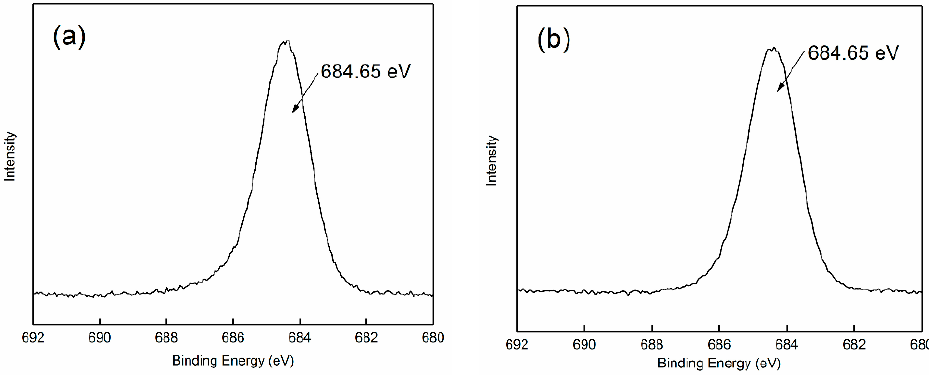
Figure 7. F 1s spectra of ( a ) untreated bastnaesite, ( b ) bastnaesite treated with strontium ions.